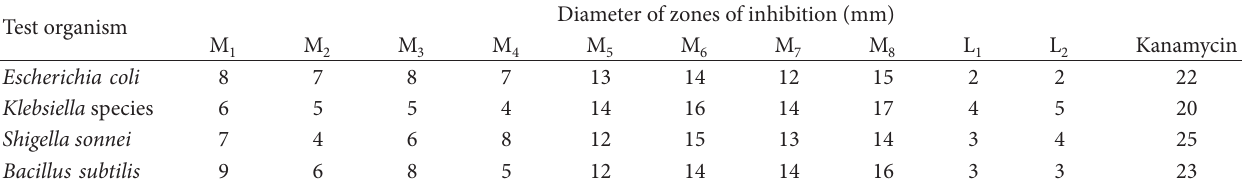
T 4: Antibacterial activity of ligands and metal